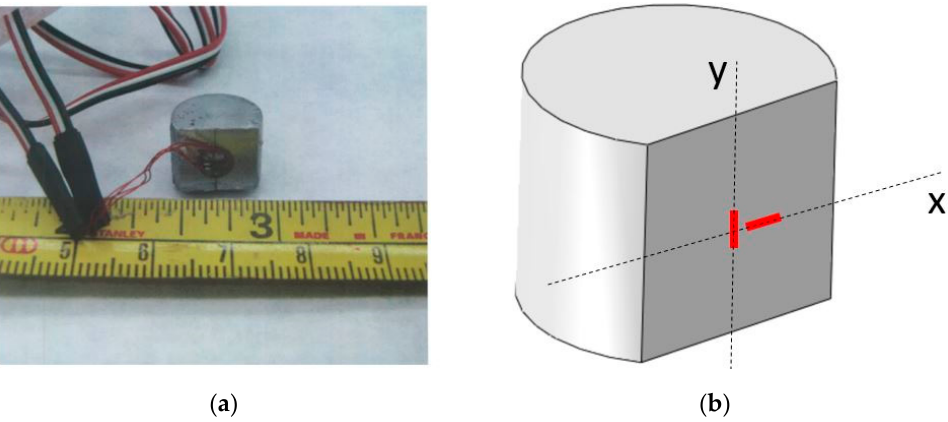
Figure 10. Compression specimen of Al–TiB 2 composite fitted with axial and transverse strain gages ( a ) strain gage directions with respect to loading direction ( b ) (y loading direction, x transverse di- rection).